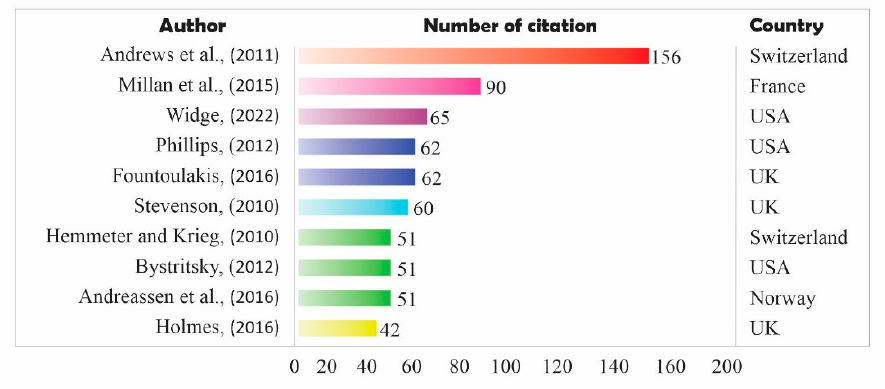
Figure 5. Top 10 article citations based on the collected database [1,8,32–39].